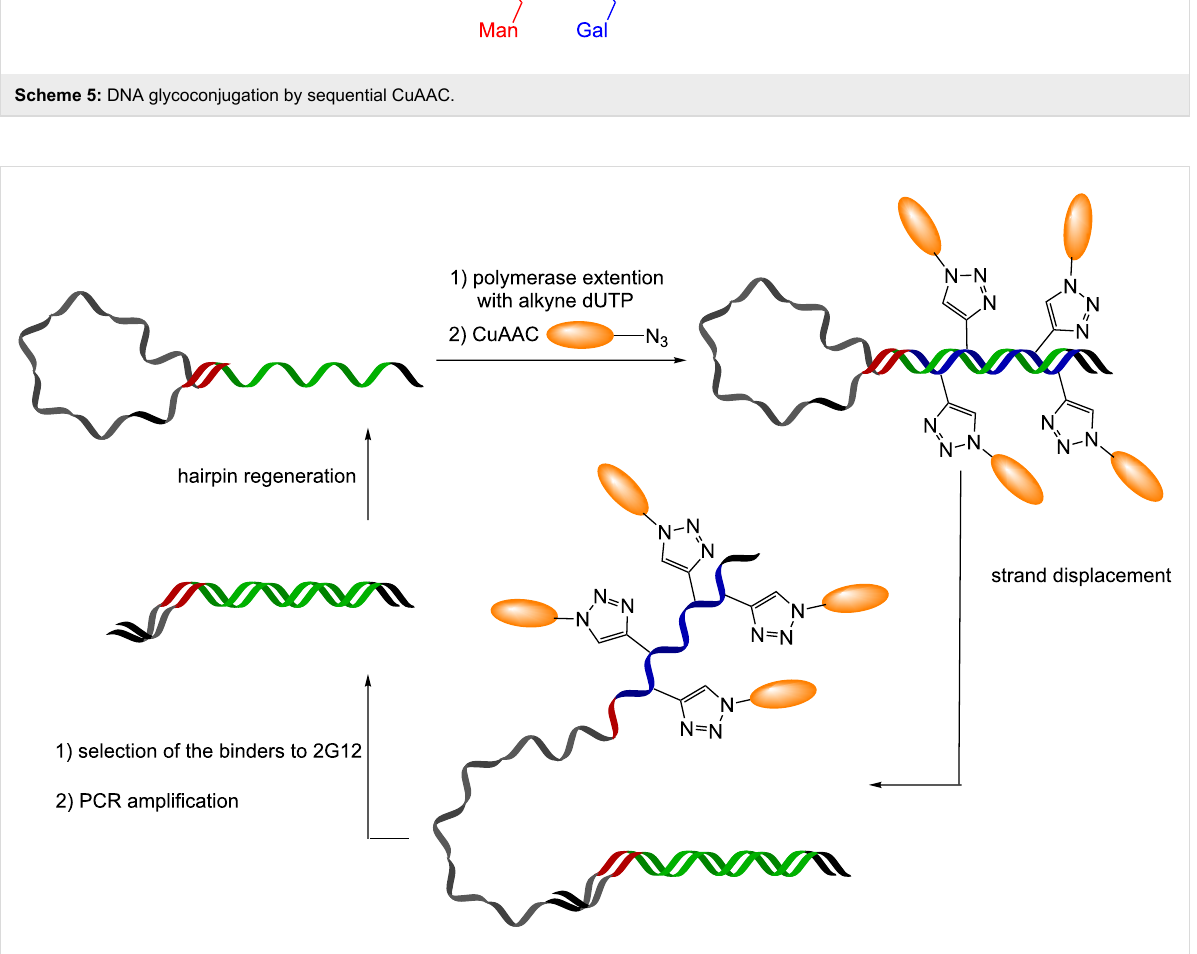
Scheme 6: Selection with modified glycoconjugate aptamers